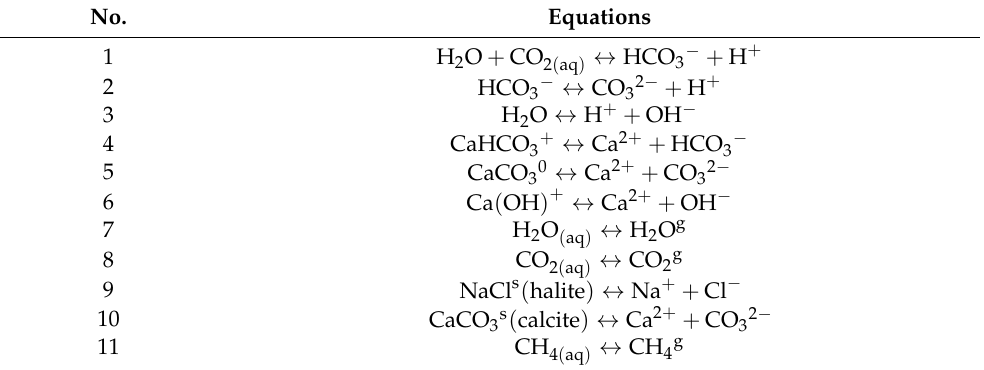
Table 1. Chemical reaction and phase change equilibrium equations involved in this simulation program. No.